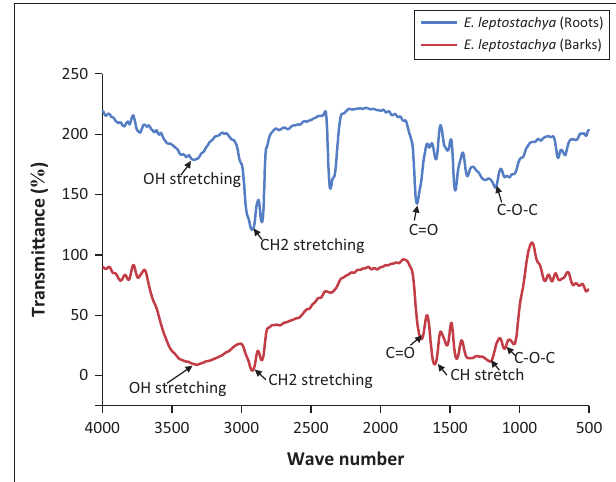
FIGURE 1: Fourier transform infrared spectra of roots and bark extracts of Entada